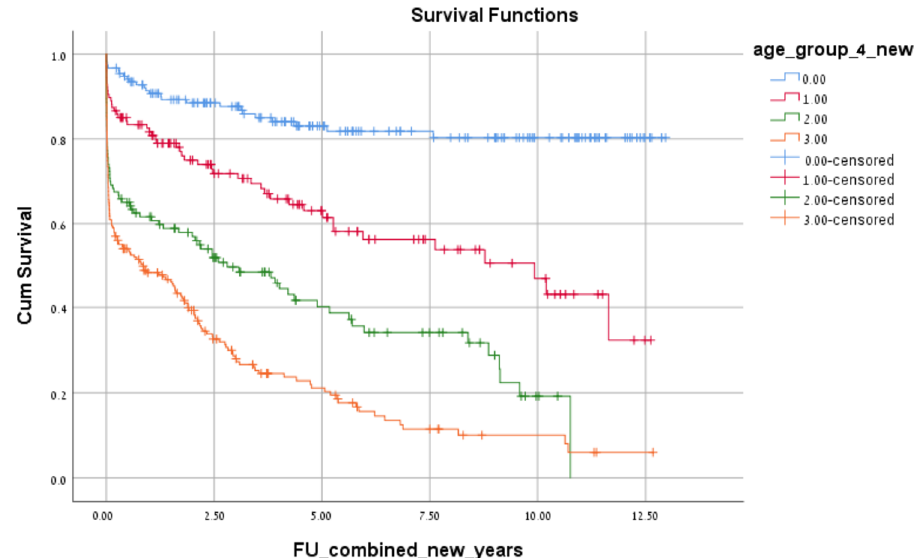
Figure 4. Overall Kaplan-Meier survival curve.